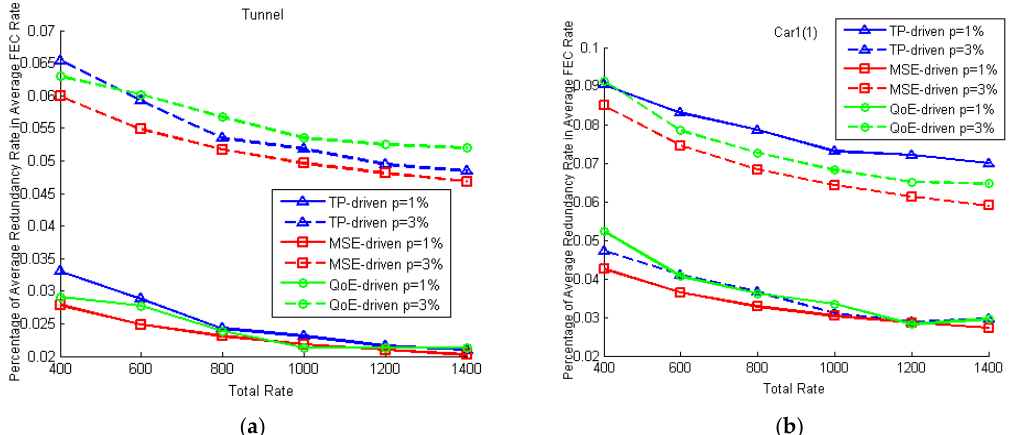
Figure 15. Percentage of FEC redundancy rates in total coding rates of Tunnel and Car1(1) under different rate constraints. In the fisrt case (solid lines), packet loss rate of each videos is 1%. In the second case (broken lines), packet loss rates of Tunnel and Car1(1) are 3%, and packet loss rates of other videos are 1%: ( a ) Percentage of FEC redundancy rates in total coding rates of Tunnel; ( b ) Percentage of FEC redundancy rates in total coding rates of Car1(1).